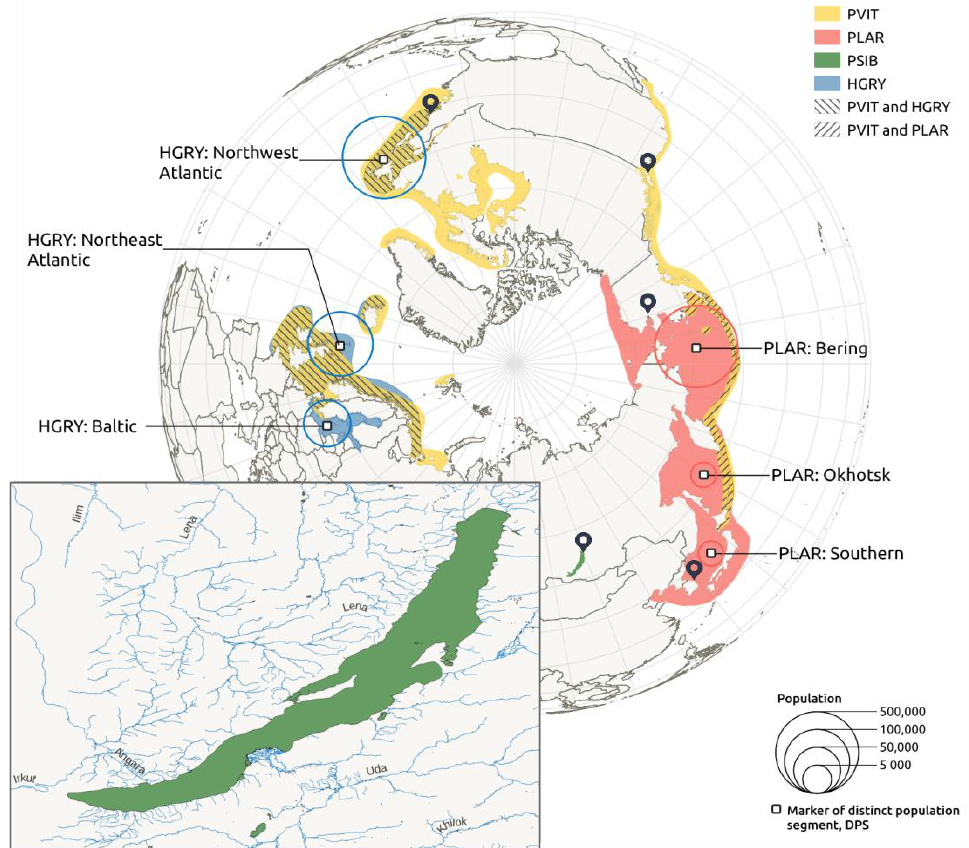
Figure 1. The geographic distributions of the four pinniped species included in this study: Baikal seal (PSIB), gray seal (HGRY), spotted seal (PLAR), and harbor seal (PVIT). Regions of habitat intersection are shown with diagonally shaded areas. Map pointers denote sample coordinates.